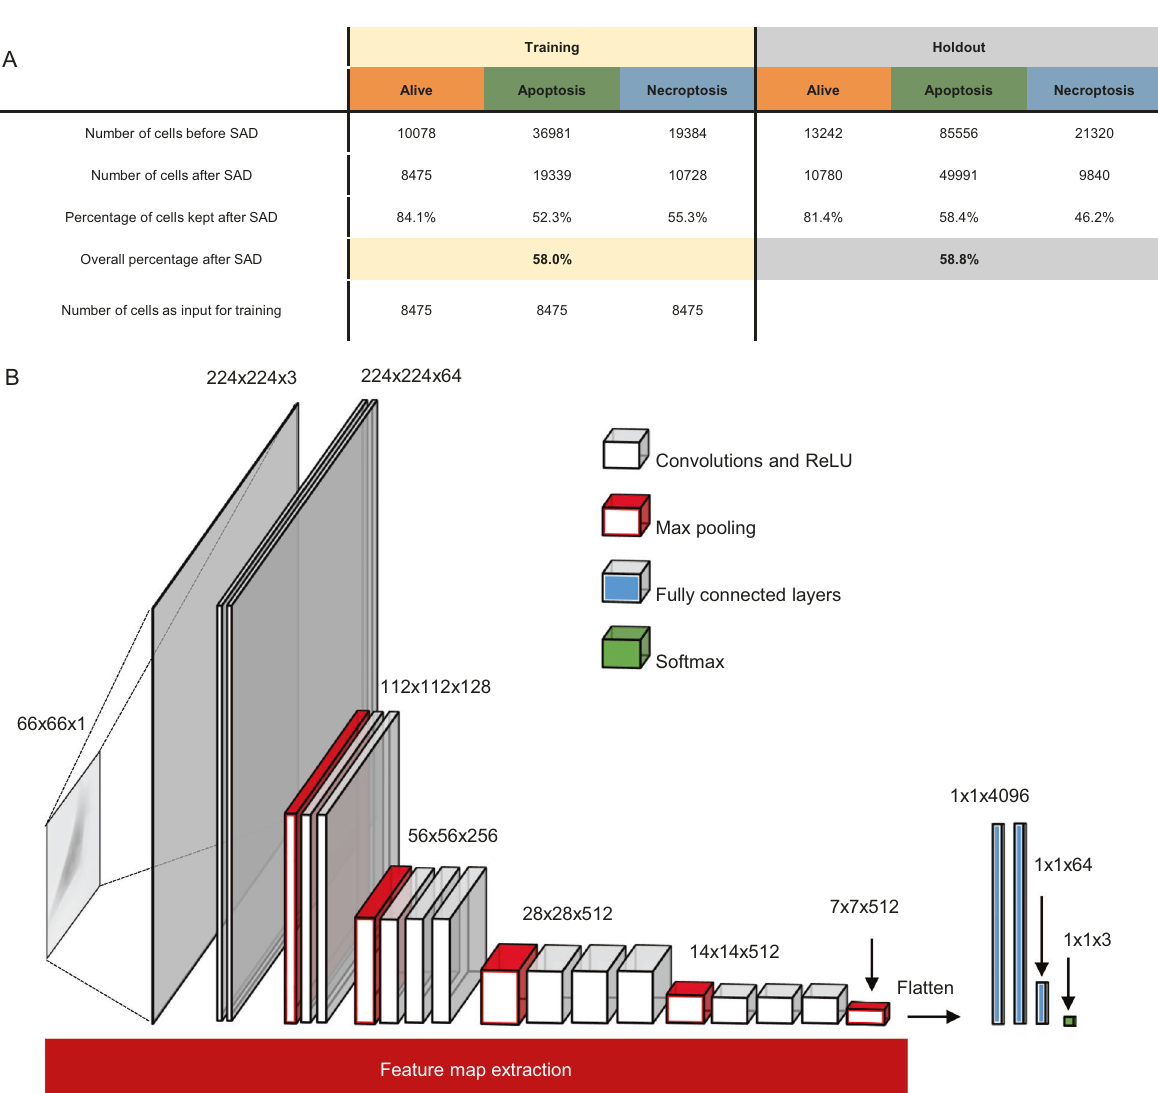
Fig. 3 The analysis pipeline, supervised anomaly detection followed by deep learning using VGG-19. A The number of cells in each category before and after fi ltering with supervised anomaly detection (SAD). On the left the numbers of cells in the training data (subdivided into the three categories) and on the right this for the holdout dataset (a set of data with independent experiments). This shows that 58% percent of cells are kept after SAD. Afterwards, the training data is trimmed to overcome unequal amounts of input and thus circumvent unbalanced training data, this is equal to the smallest category of the training set. This trimmed dataset is used for the learning process as seen in Fig. 4. B A schematic representation of VGG-19 with several steps of convolution, activation and maximal pooling from left to right. This shows several steps within the convolutional neural network, starting from an image (left). Here, the cropped cells are used with the size of 66 × 66 pixels, these are resized to 224 by 244 over three channels to match the input size of the VGG-19 groundworks. After resizing the input, there are several blocks of convolution to extract information from these images. This is done by applying a convolution matrix on top of the original image which takes into account the values of surrounding pixels to recalculate and accentuate the image. Followed by activation of a recti fi ed linear unit (ReLU), this will eliminate negative values after convolution. Max pooling, uses a 2 × 2 matrix to fi nd and select the highest of these four values and thus reduces the size of the image stack by two in both width as height. This can be seen in the image as well at every max pooling step (indicated in red), the height and width are divided by two and the depth is multiplied by two. This creates different sizes of image stacks moving further into the feature map extraction. In this model these two combinations (convolutions + ReLU and max pooling) always follow up on each other. This is done to non-linearize the outputs of each convolution and to optimize the predictive value of the model. After all the convolution steps, the image stack (at the end of the convolutions of size 7x7x512), is fl attened to be used in the following step of the model and neural network part of the Convolutional Neural Network: the fully connected layers. Nodes from each layer are connected to all nodes of the next layer of this neural network. Each node gets input from the previous layer and will provide an output towards the next layer of the network. Lastly, the softmax layer is applied, which is able to convert the neural activations into probabilities per category, or in other words, a